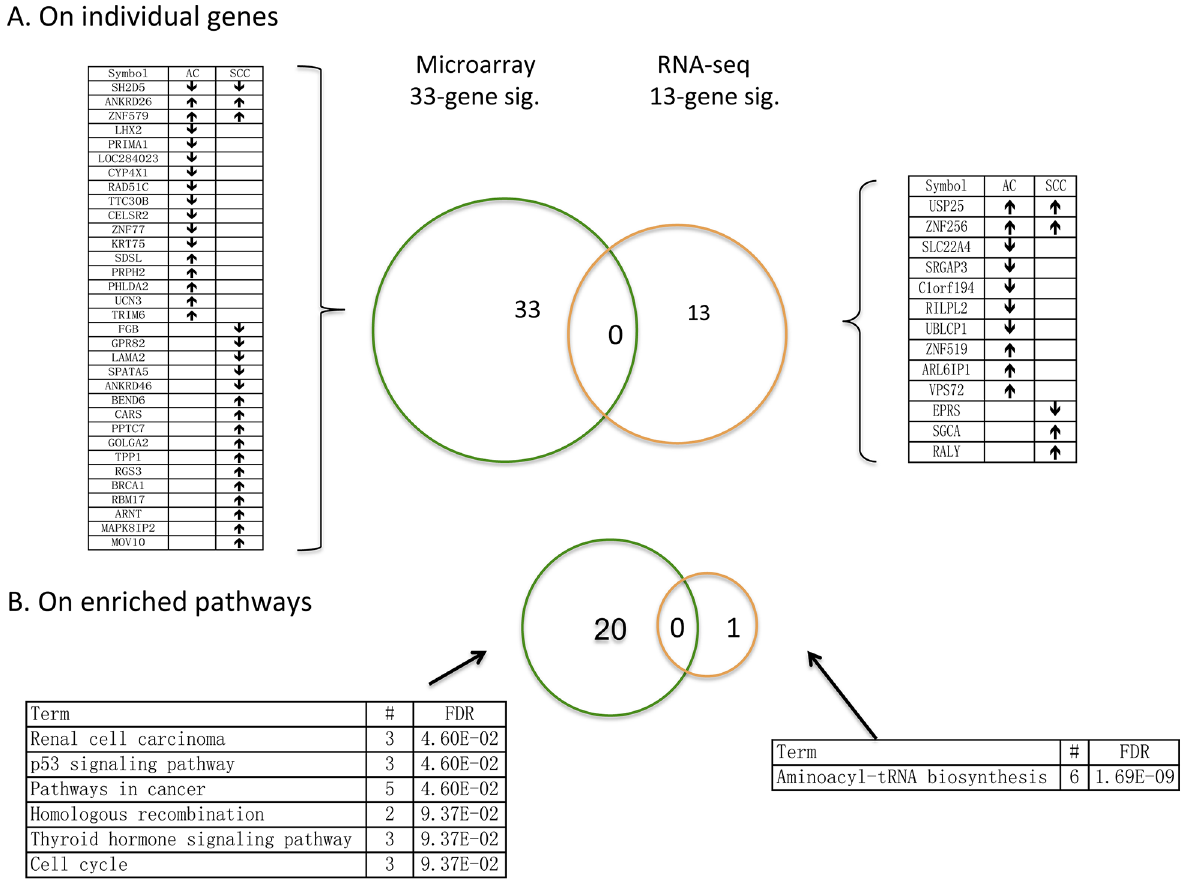
Fig 2. Venn diagrams of 33- and 13-gene signatures. A) On the individual gene level. B) On the enriched pathway level. 33-gene and 13-gene signatures were obtained using Cox-TGDR-specific algorithm with one being trained on the microarray data and the other on the RNA-seq data. Here, # and " indicate a negative and positive association with hazard of death,